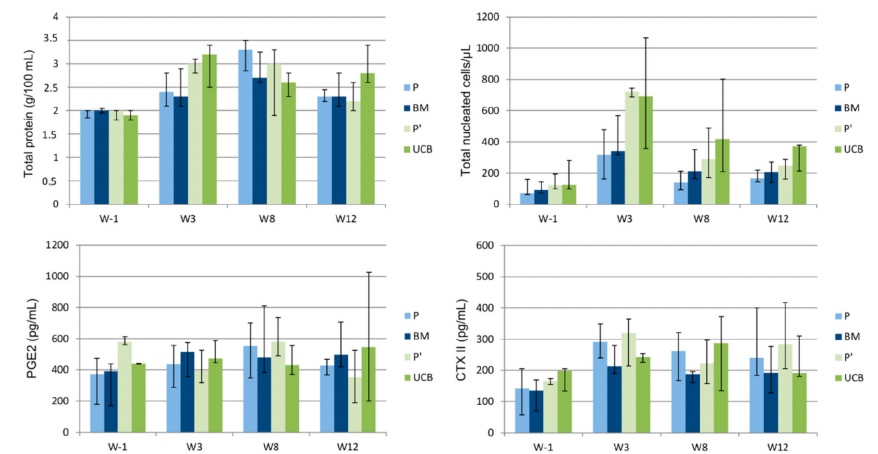
Figure 6. Evolution throughout the study period of the median values (1st quartile- 3rd quartile) of synovial fluid parameters displayed per treatment group. W—Week; P—Fetlocks injected with placebo, contralateral of the fetlocks injected with bone-marrow derived mesenchymal stem cells (BM-MSCs); BM—Fetlocks injected with BM-MSCs; P’—Fetlocks injected with placebo, contralateral of the fetlocks injected with umbilical cord blood derived mesenchymal stem cells (UCB-MSCs); UCB—Fetlocks injected with